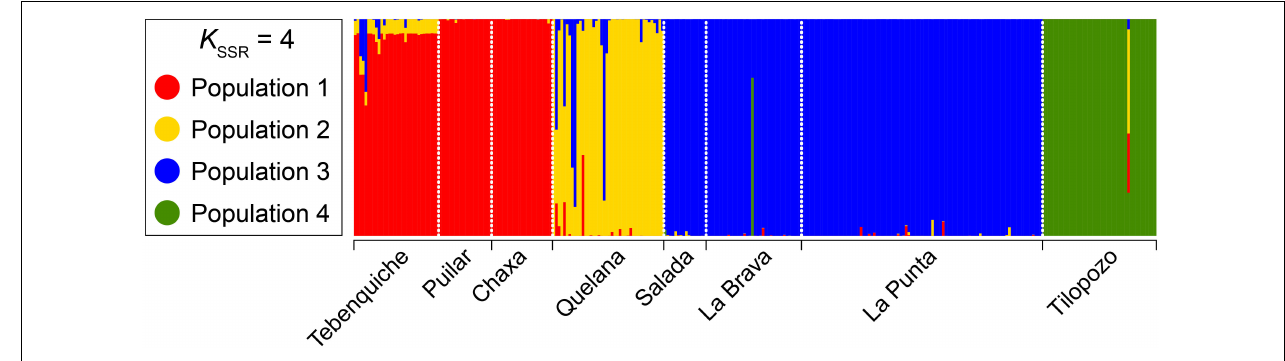
FIGURE 4 | Population structure inferred for gastropods of the genus Heleobia of the Atacama Saltpan obtained from 11 microsatellite loci using